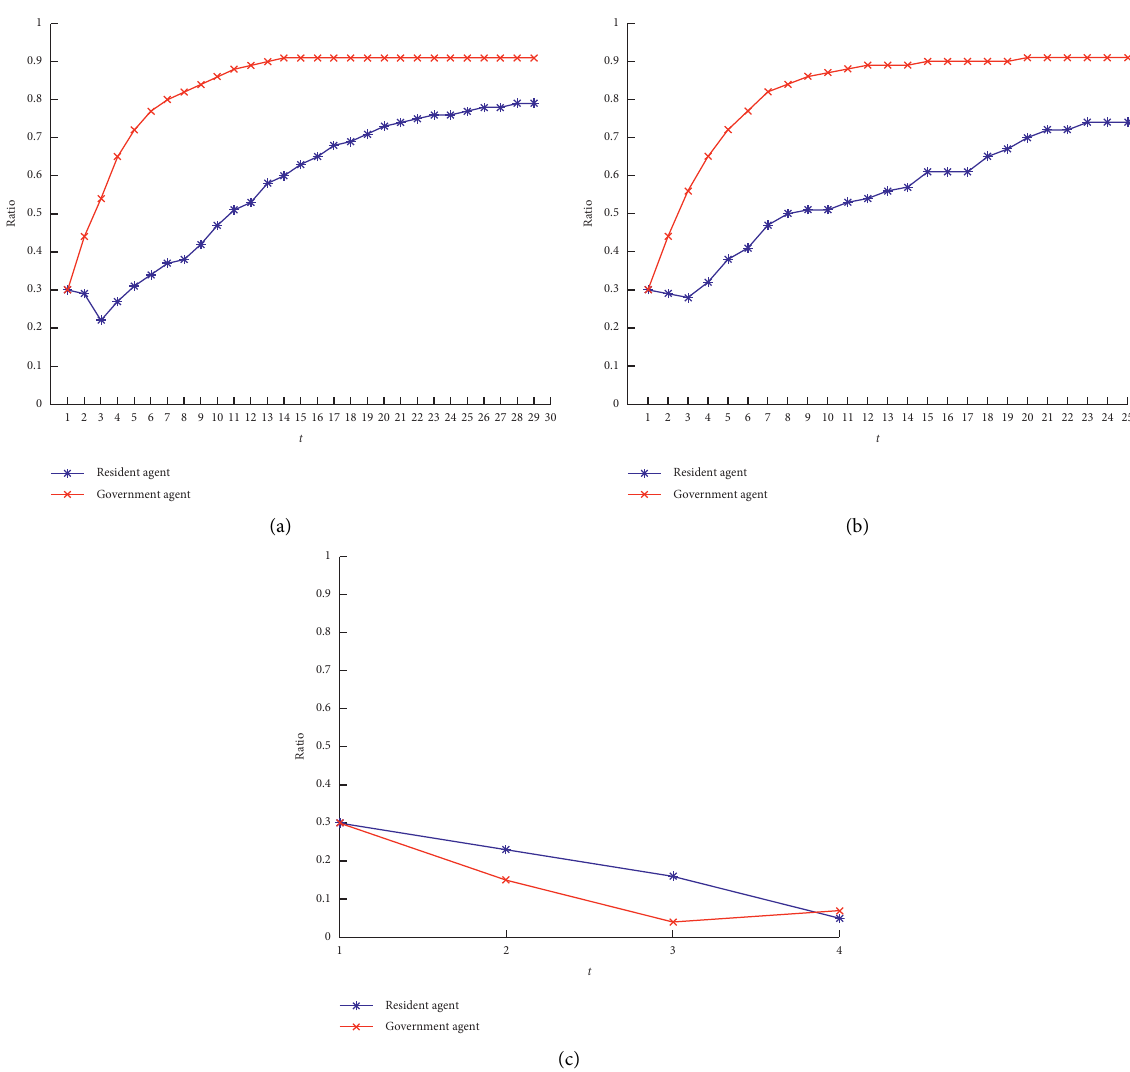
Figure 10: The evolution with the different S . (a) Evolution with S � 120. (b) Evolution with S � 240. (c) Evolution with S �